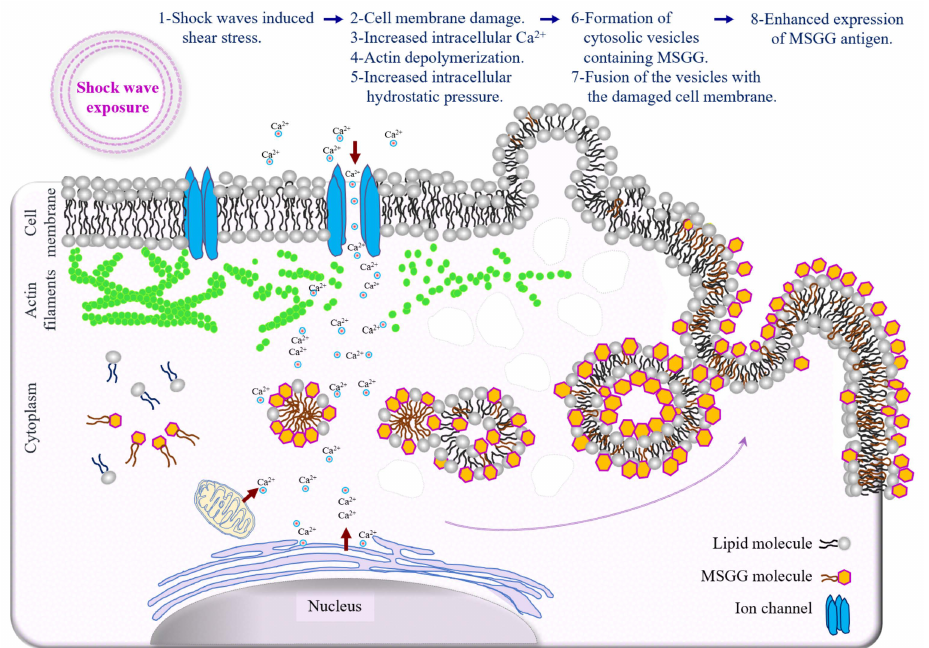
Figure 9. Schematic diagram depicting the mechanism of acute mechanical modification of GSL- MSGG expression on the cell membrane of renal cell carcinoma. Increased membrane tension by shear stress and shock wave interaction with intracellular structures can directly trigger a cascade of events, which begins with mechanical damage to the cell membrane, followed by an influx of extracellular Ca 2+ , damage to the cytoskeleton and increased intracellular hydrostatic pressure, which can induce cytosolic flow; lipid aggregation in the cytoplasm; vesicle formation; and incorporation of lipid molecules, including MSGG, with newly formed vesicles. Finally, fusion of the vesicles containing MSGG with the cell membrane to repair the damaged area can cause increased expression of MSGG on the cell